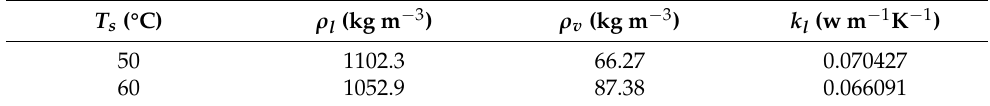
Table 6. Thermophysical characteristics of R134a at 50 and 60 ◦